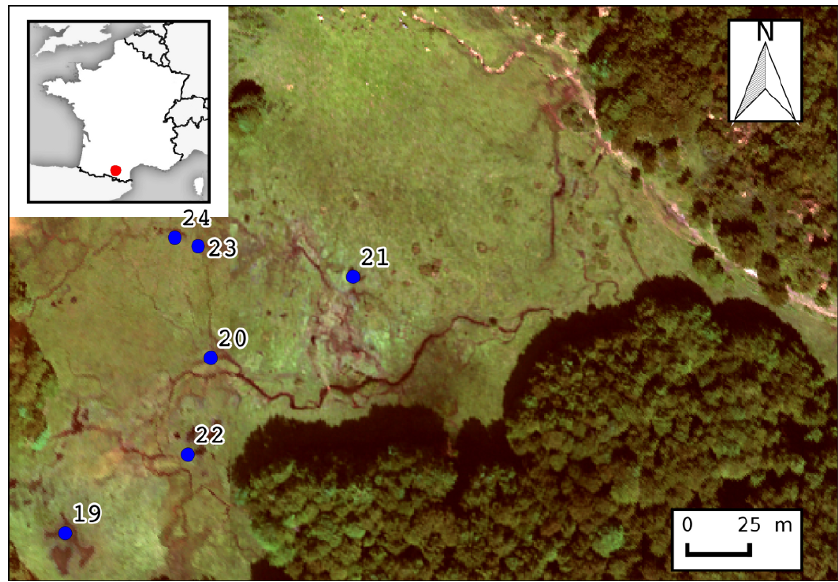
Figure A17. Location of the in situ spectroradiometer measurements for the plots of Aquatic type a (AQ_A).